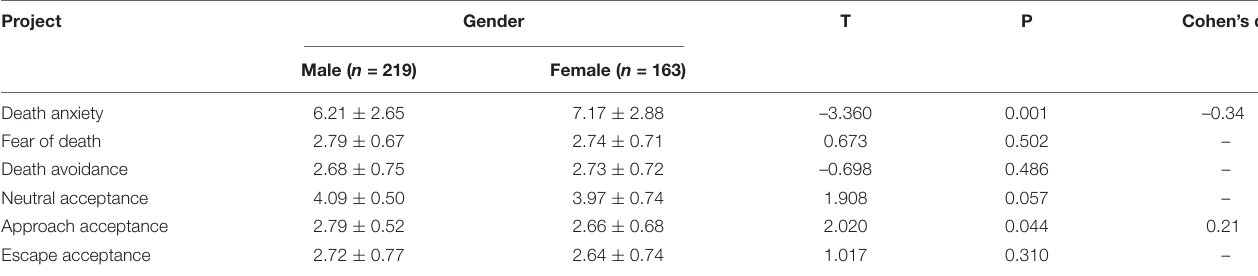
TABLE 2 | Results of death attitude and anxiety in different sex. Project